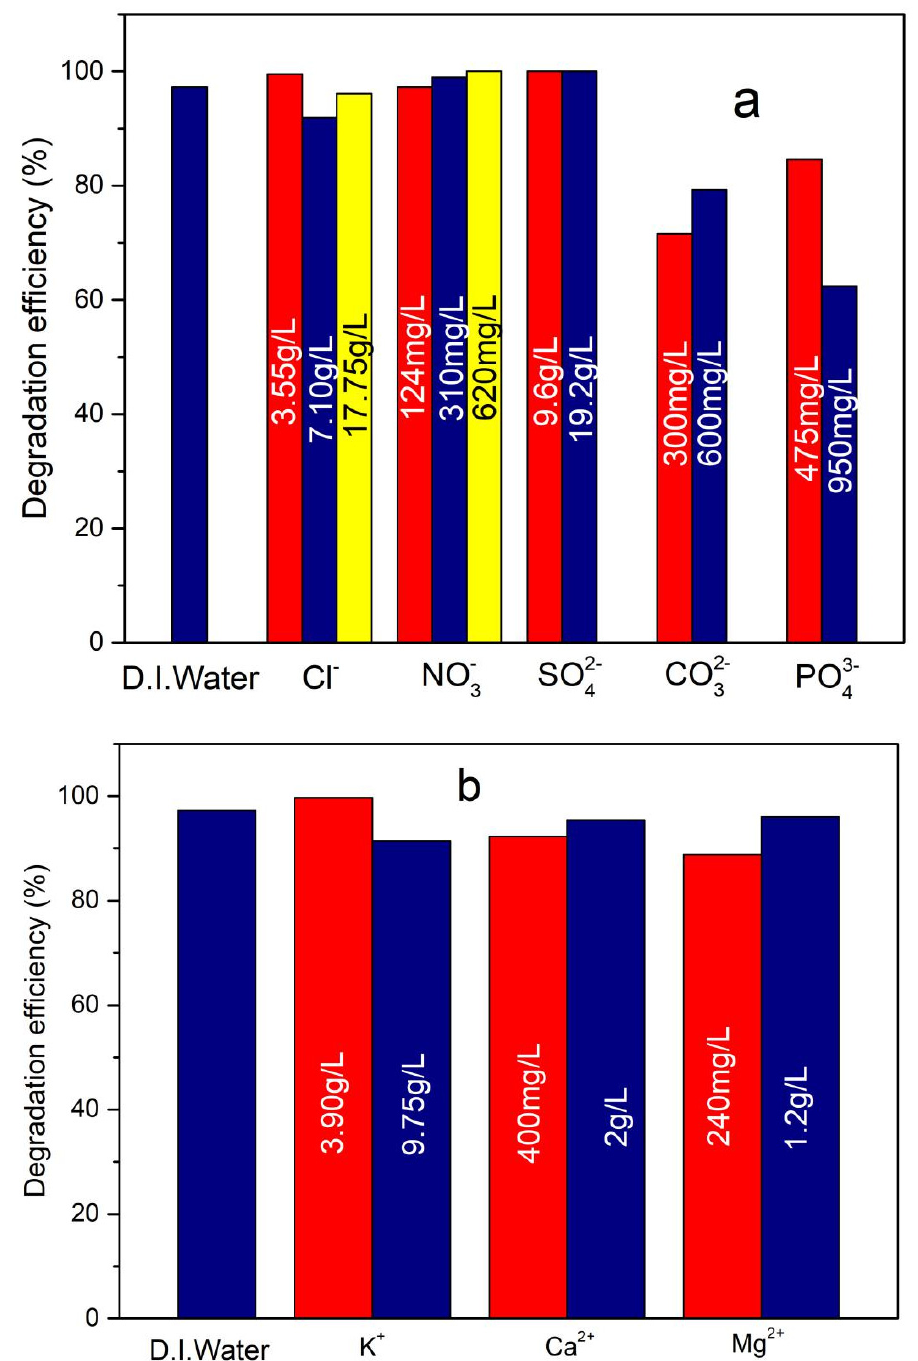
Figure 6. Effects of anions and cations on 2,4-DCP degradation. ( a ) Anions; ( b ) cations. [2,4-DCP] = − 1 , [Fe(III)-EDDS] = 0.1 mM, [H ± 20 mg L − 1 , [Fe(III)-EDDS] = 0.1 mM, [H 2 O 2 ] = 1.0 mM, and pH = 7.0 ± 0.1. [2,4-DCP] = 20 mg L 2 O 2 ] = 1.0 mM, and pH = 7.0